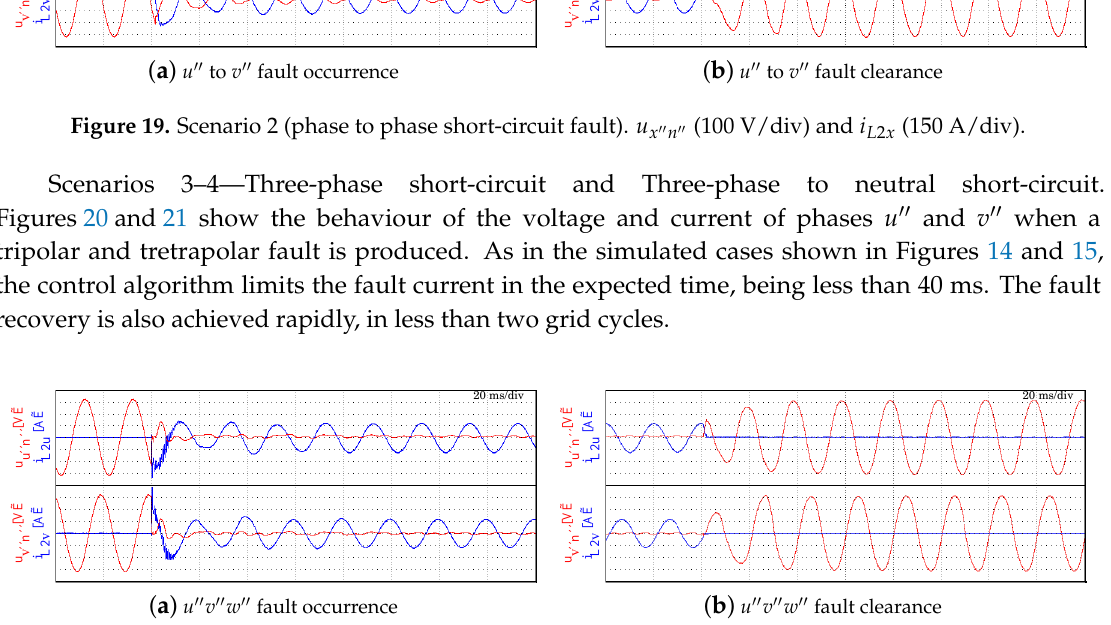
Figure 20. Scenario 3 (three-phase short-circuit). u x (cid:48)(cid:48) n (cid:48)(cid:48) (100 V/div) and i L 2 x (150